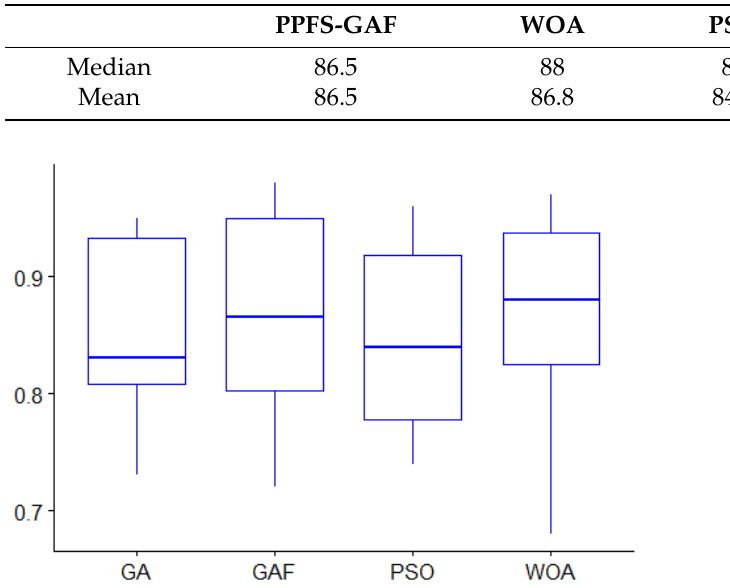
Figure 10. Boxplot of the accuracy obtained by k-NN after applying PPFS-GAF, WOA, PSO, and GA for 8 datasets. The y-axis represents the minimum, first quartile, median, third quartile, and maximum value of the accuracy